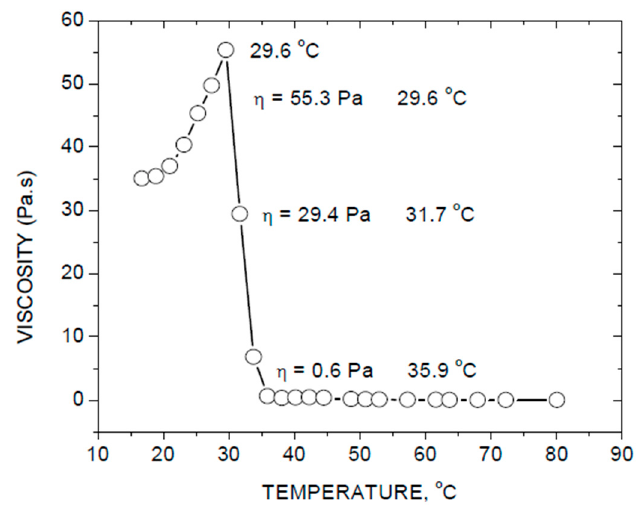
Figure 3. Rheological test for viscosity ( η ) of the gel obtained from the treated dye solution (AB45) upon heating. The curve represents the variation of η of the gel with temperature increasing from 15 to 80 °C.